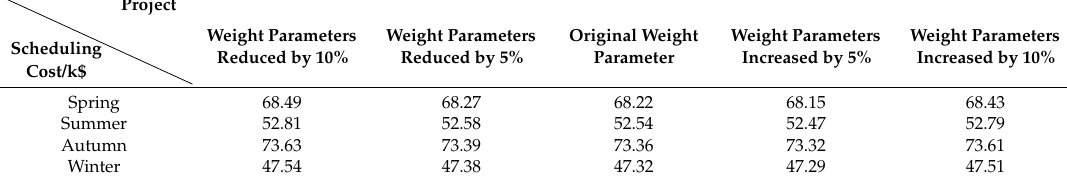
Table 12. Cost of scheduling model under different weight